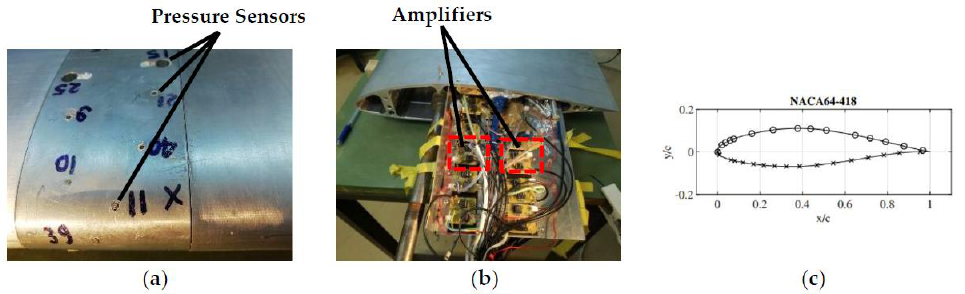
Figure 4. ( a ) Pressure transducers at the suction side, ( b ) signal amplifiers in the interior of the wing, ( c ) locations of pressure transducers.